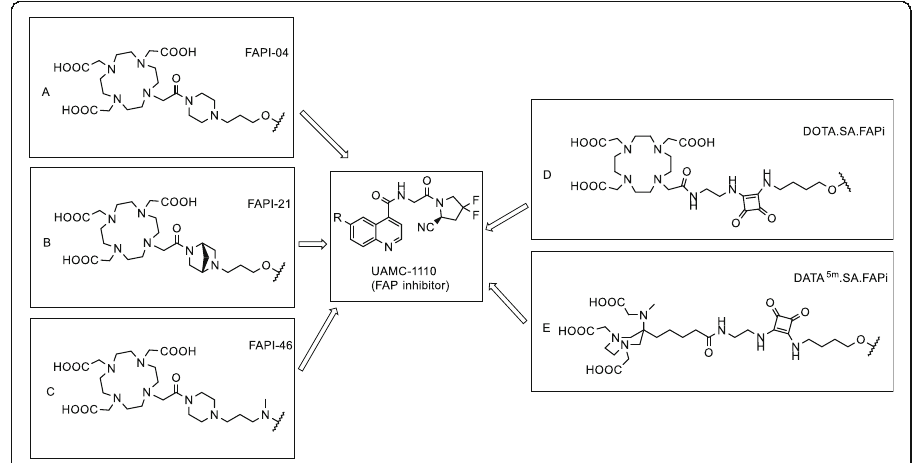
Fig. 2 Structural comparison of chelator-linker conjugates coupled with UAMC1110 (FAP inhibitor). a FAPI-